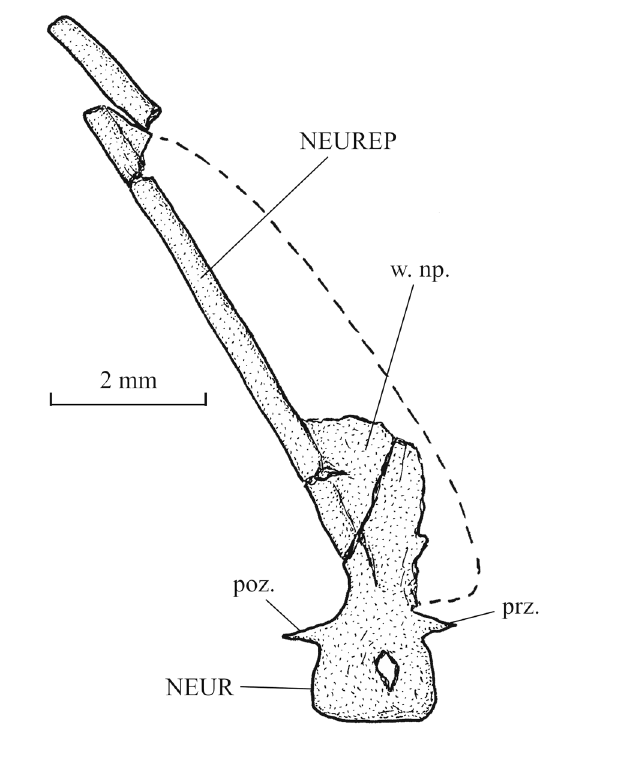
Fig. 7. Libanopycnodus wenzi gen. et sp. nov., holotype, eighteenth neural arch and spine (CLC